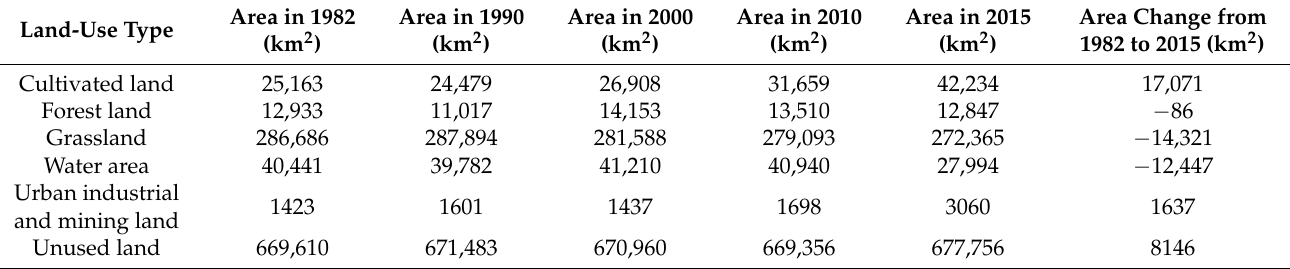
Table 1. Area changes of different land-use types in southern Xinjiang from 1982 to